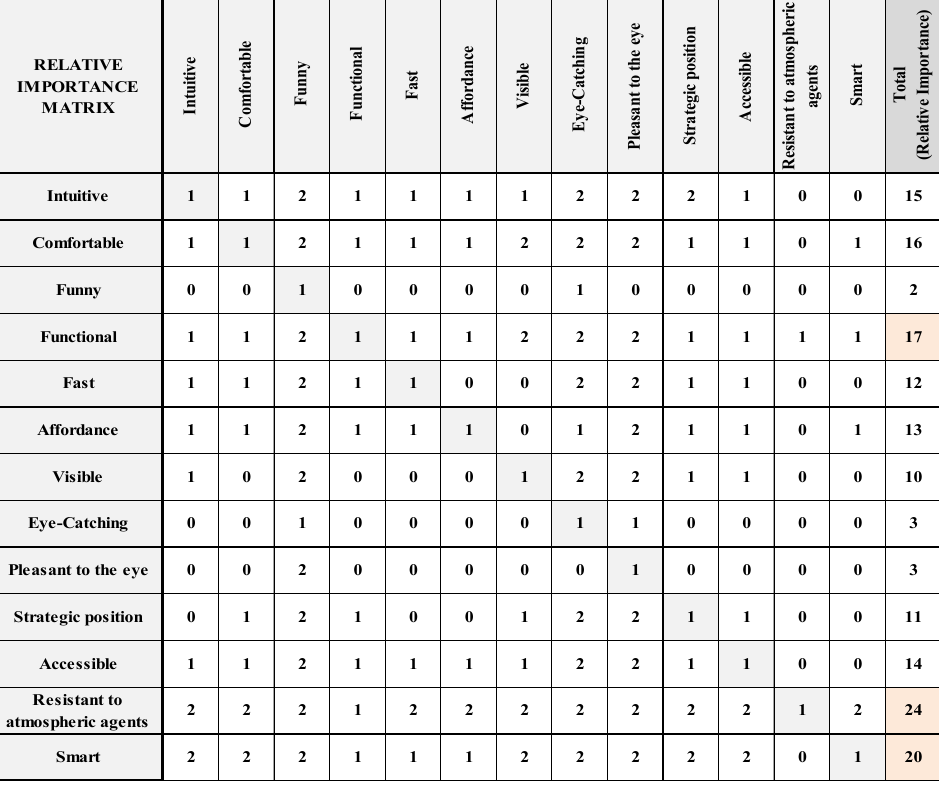
Table 1. Six Questions.